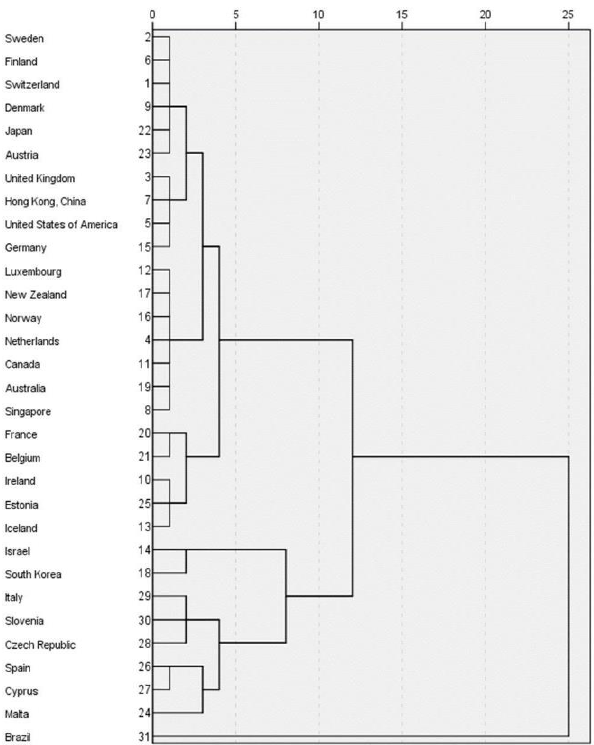
Figure 7 . Formation of Clusters of the Most Innovative Countries (in 2013) and Brazil‟s